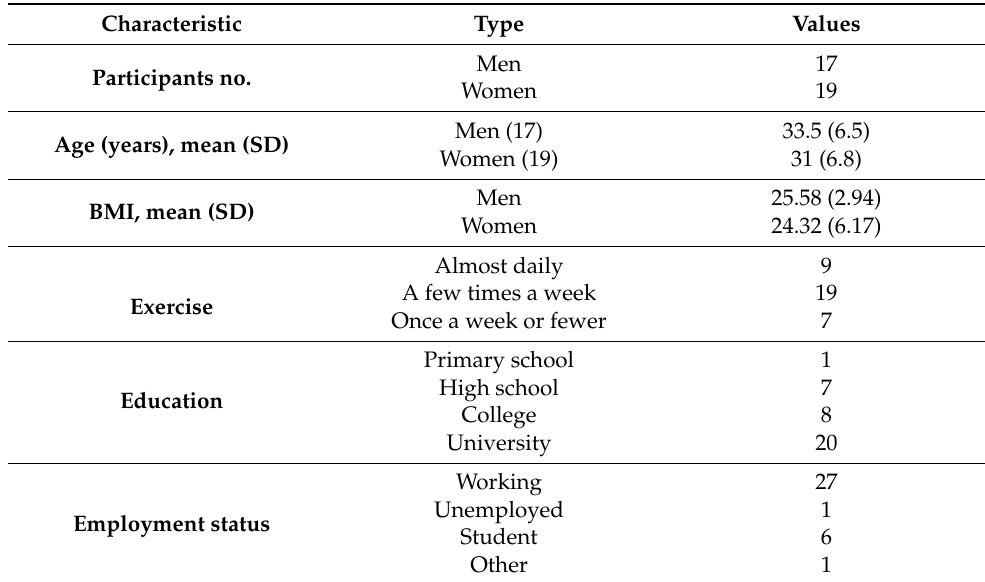
Table 1. Background information of the